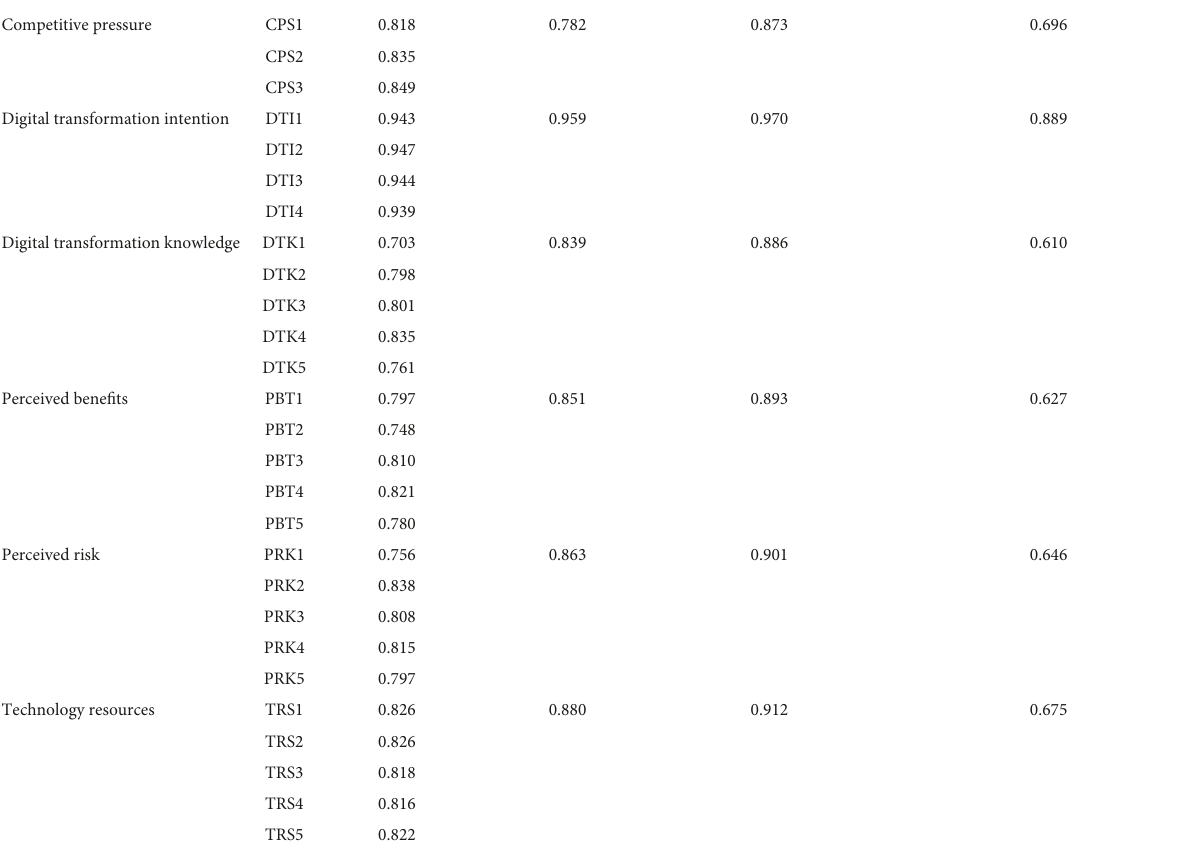
TABLE 2 Reliability and convergent validity.